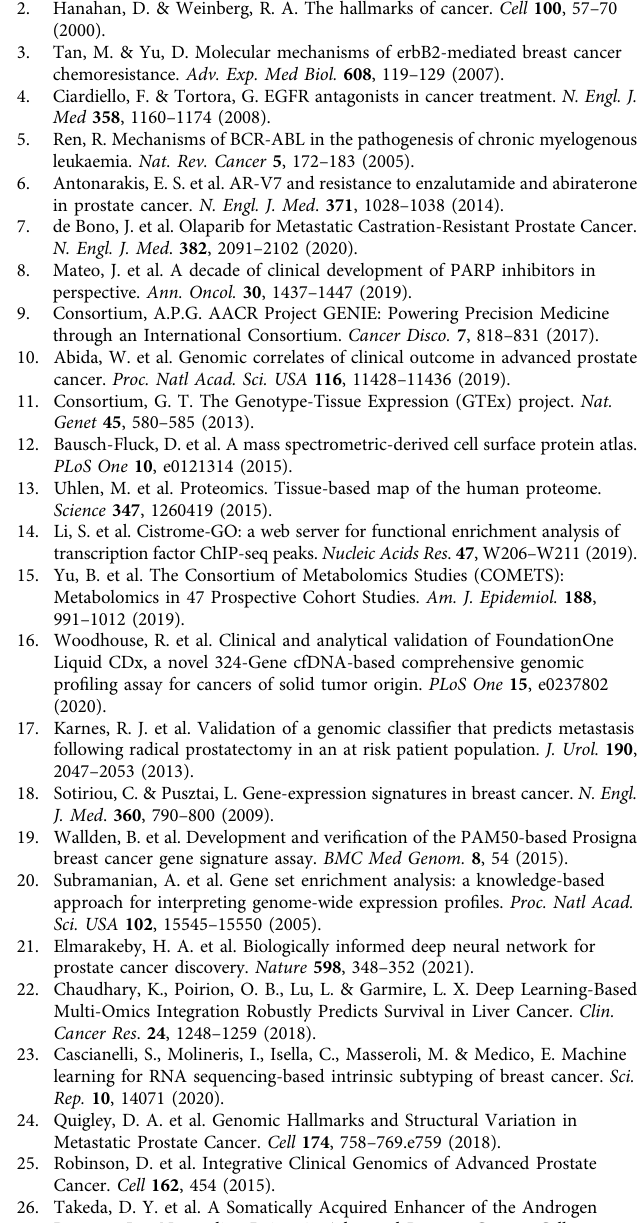
Supplementary Figure 1a are available in Supplementary Information Table S2 of the original manuscript. https://doi.org/10.1016/j.ccell.2019.02.005 (2019) 28 . The data used to generate the fi gures in this manuscript are available in Supplementary Data